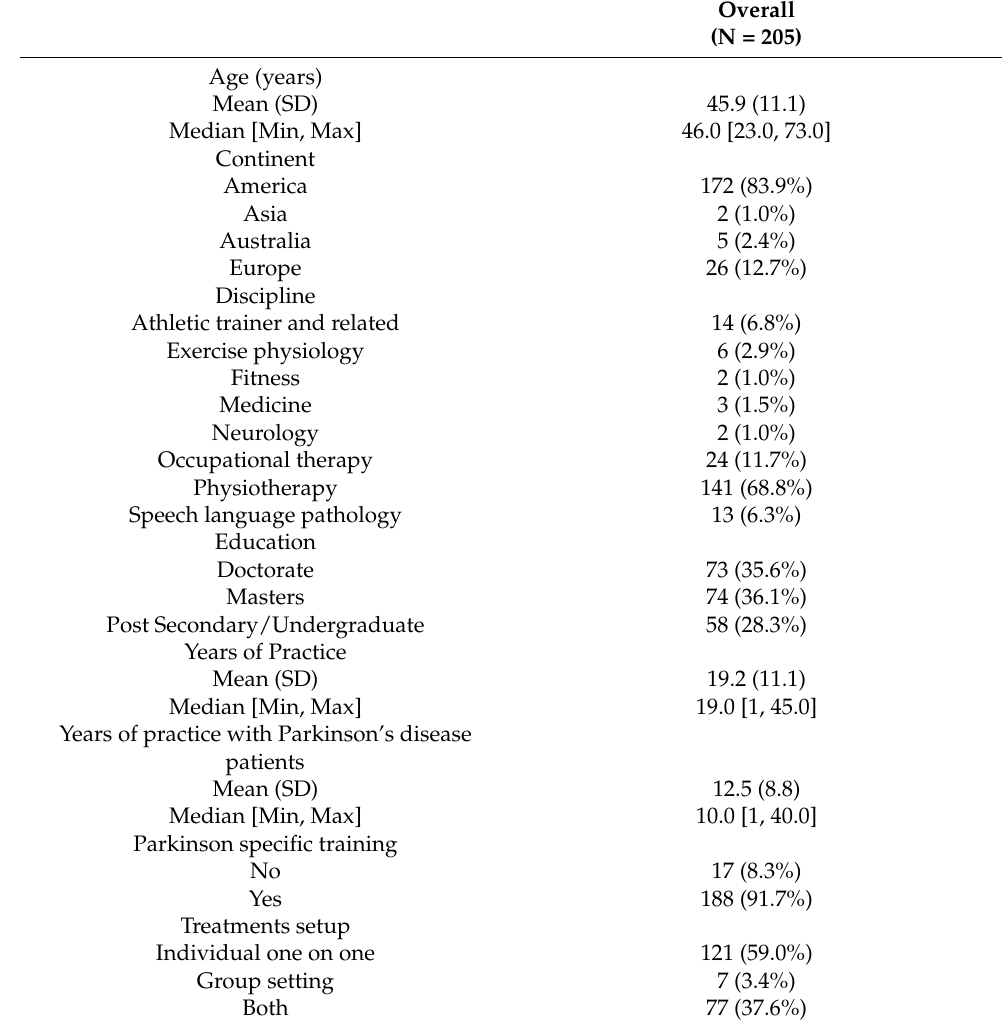
Table 1. Characteristics of the participants.